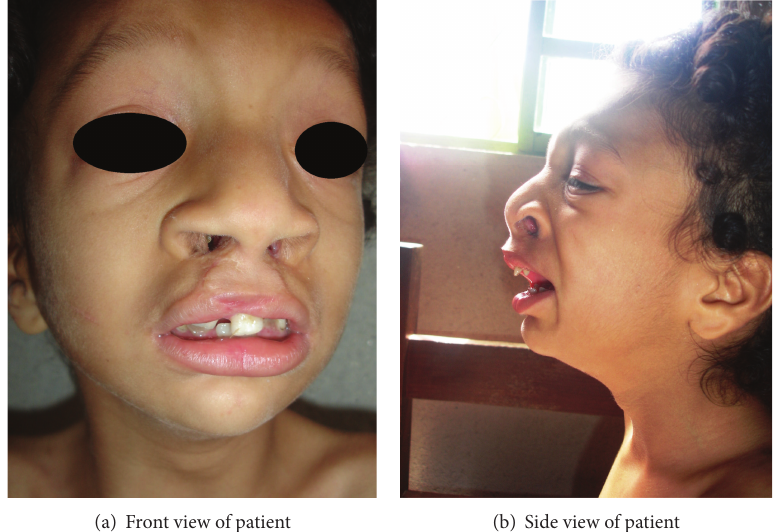
Figure 1: Patient at age of 8 years. Note craniofacial dysmorphism, bilateral transforaminal cleft (cheiloplasty and palatoplasty had been previously performed), high forehead, hypertelorism, low set ears, strabismus, and large nasal bridge with anteverted